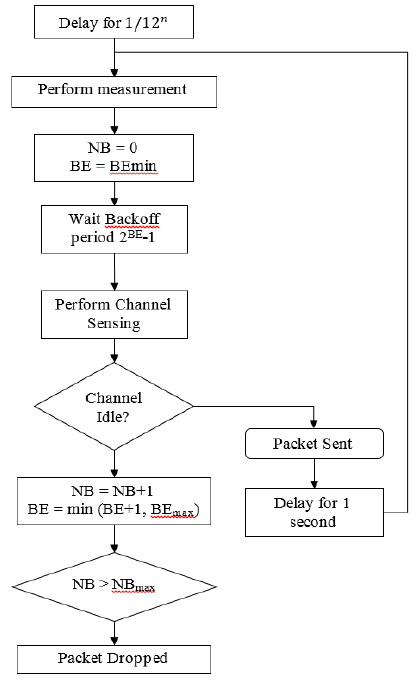
Figure 5. WSN transmitting flowchart; where BE is backoff exponent and NB is the number of successive backoffs before current